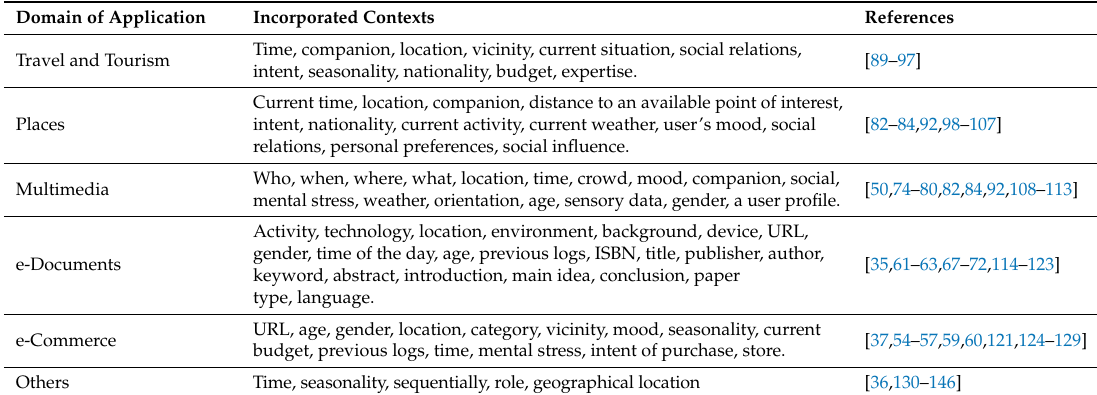
Table 2. Domains of application with their incorporated